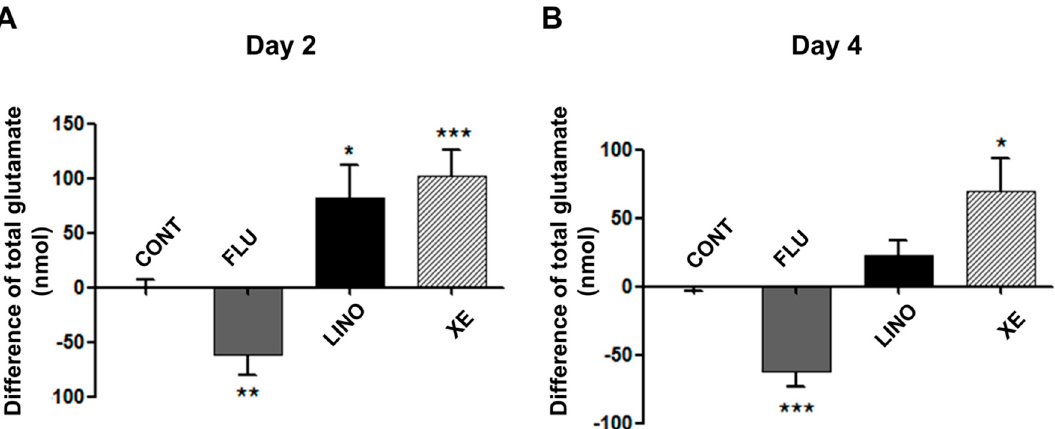
Figure 10. Effect of K V 7 channel on glutamate release during osteoblastic differentiation in MG-63 cells. ( A ) On day 2, flupirtine (30 µ M) significantly decreased glutamate release after inducing osteoblastic differentiation ( n = 6). However, linopirdine (30 µ M) or XE991 (10 µ M) caused significantly increased glutamate release ( n = 5); ( B ) On day 4, flupirtine also caused decreased glutamate release ( n = 5), whereas XE991 notably increased the extracellular glutamate ( n = 7). Linopirdine augmented the amount of glutamate, but not statistically significantly ( n = 8). The values are presented as mean ˘